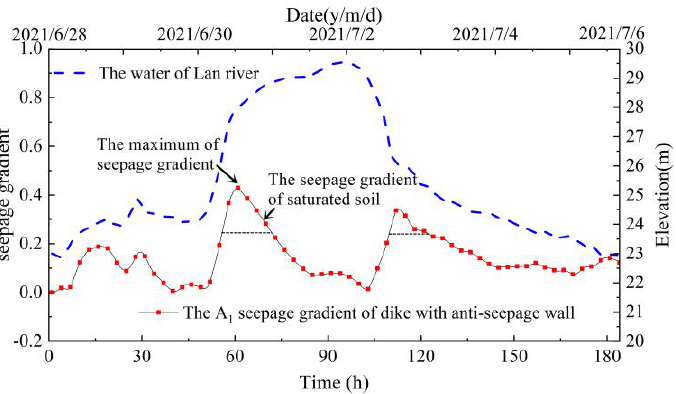
Figure 20. Variation curve of hydraulic gradient at point A 1 after lime grouting between ancient dike and antiseepage well. and antiseepage